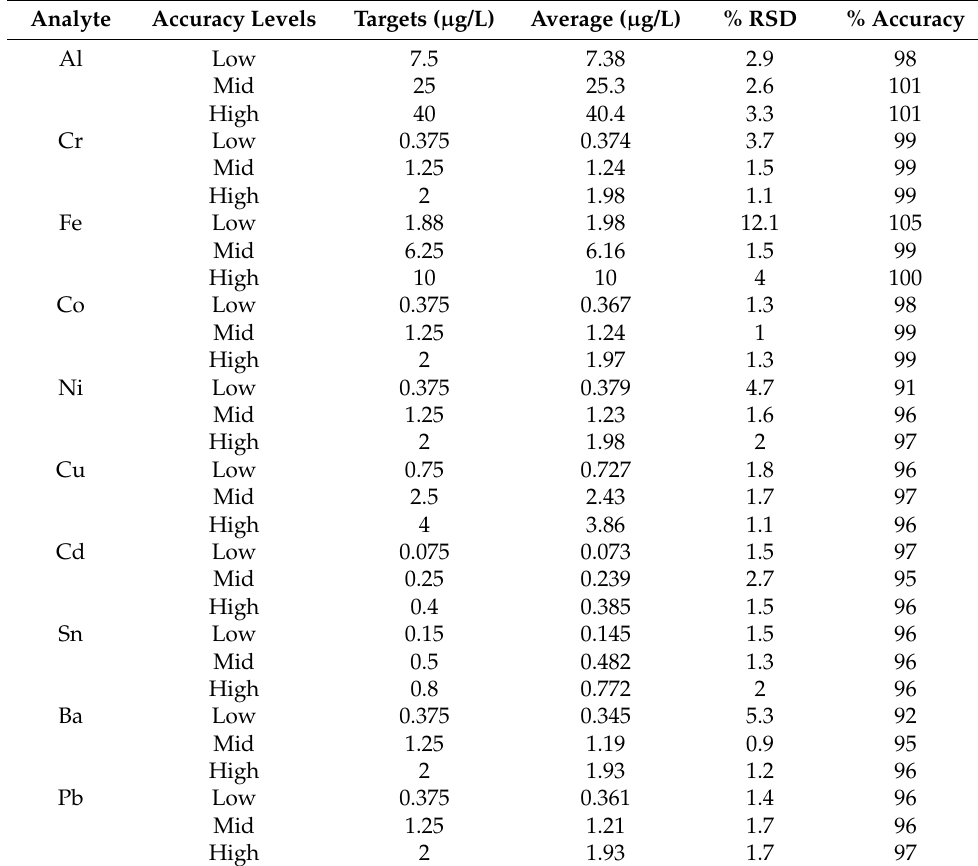
Table 2. Accuracy results for spiked aqueous